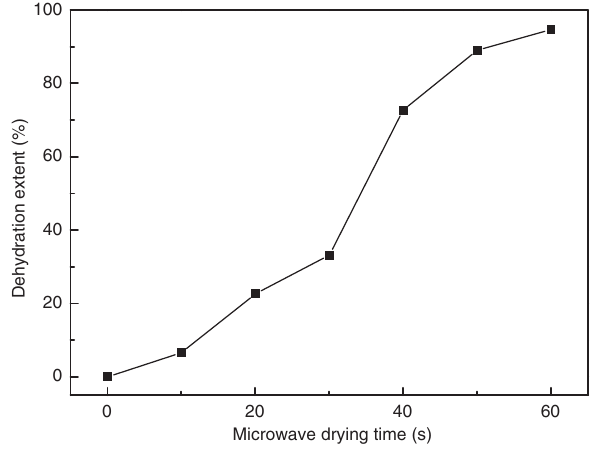
Figure 10: Effects of microwave drying time on dehydration extent of high titanium slag (microwave power: 700 W; bed depth: 10 mm; sample mass: 200 g).